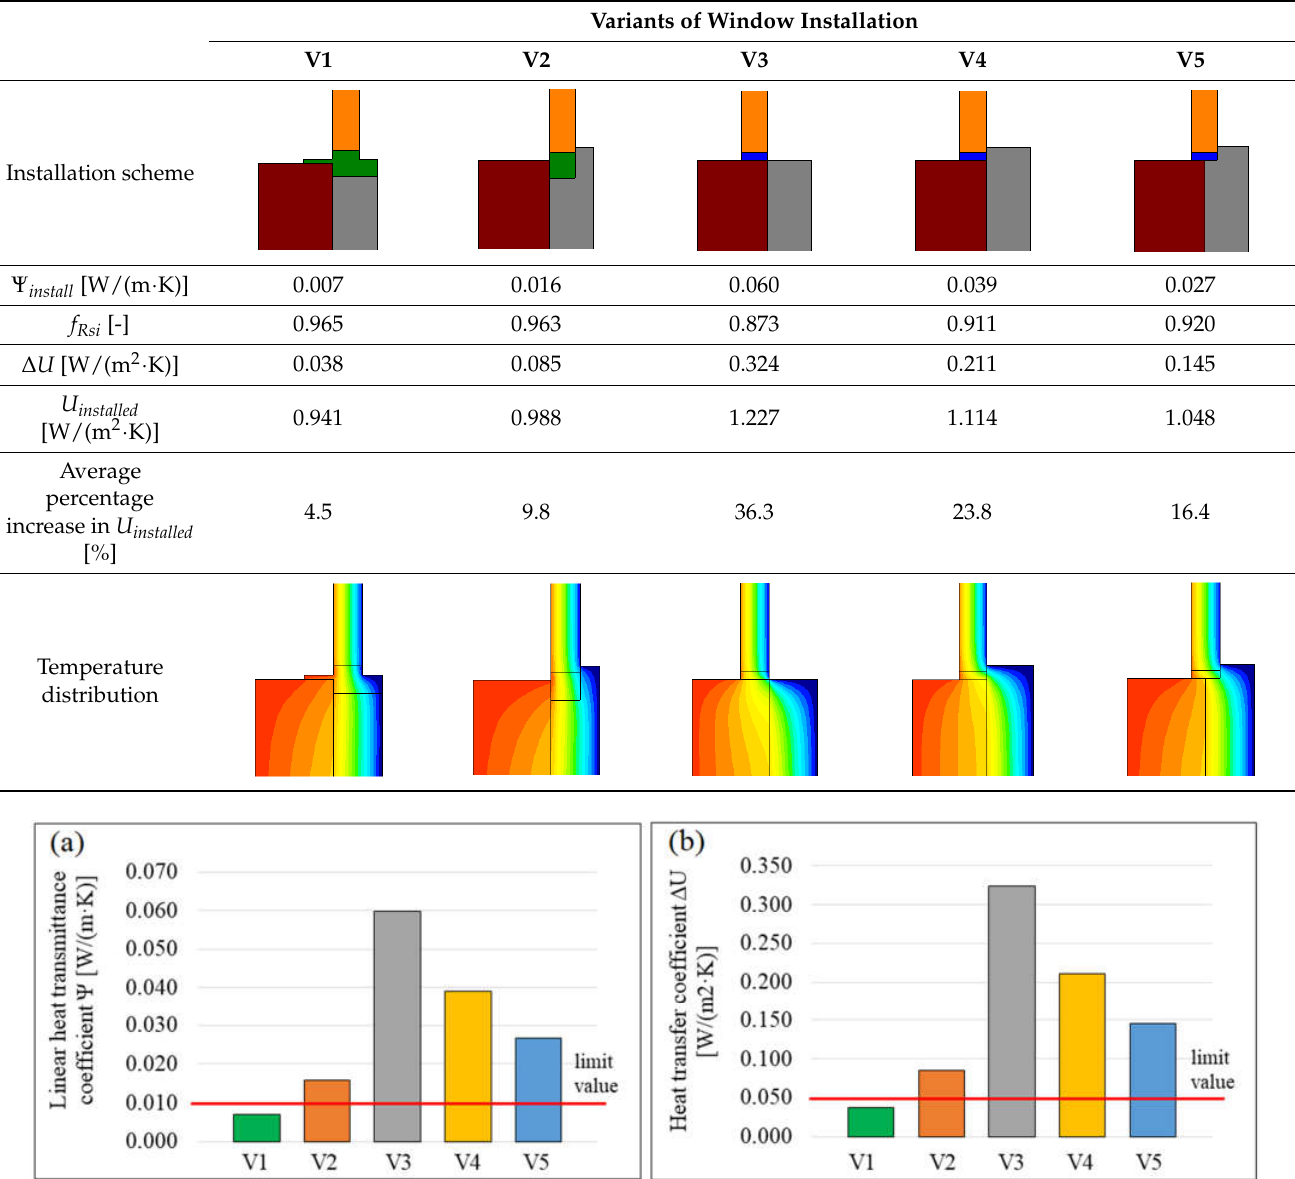
Table 2. Comparison of thermal parameters of analysed variants of window installation.